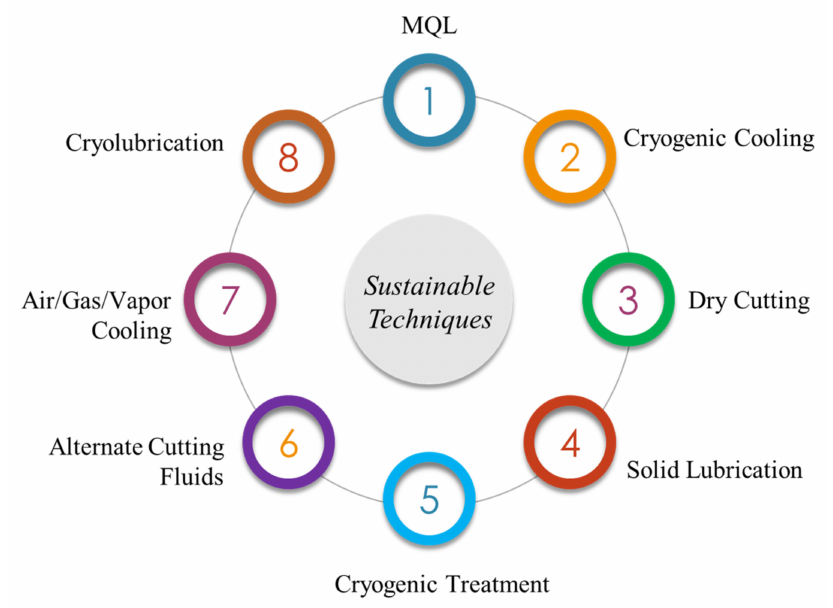
Figure 10. Sustainable Techniques, reprinted with permission from ref. [8]. Copyright 2015 Else- vier